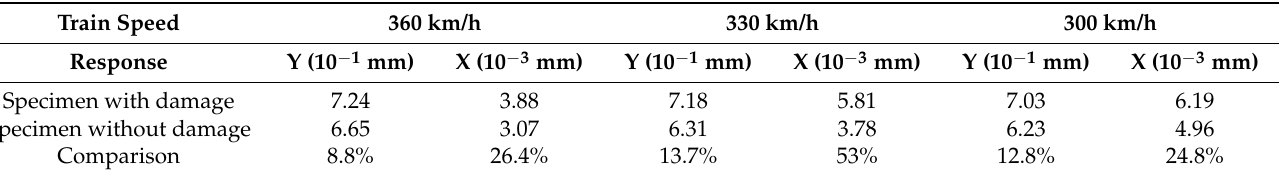
Figure 28. Responses of the composite beam at a train speed of 300 km/h in the case of T-2. 5. Conclusions In this paper, an elaborate FEM of a composite beam with group studs is established based on the ABAQUS platform, and an “M” type cyclic load is applied. On this basis, the FEM of the push-out and pull-out tests of the existing damaged and undamaged local specimens was established. Then, a numerical simulation was carried out to analyze the concrete slab damage and the degradation of the connection. The coupling system of a high-speed train ballastless track–composite beam was established, in which the macro- scopic constitutive model of the connection was introduced. Finally, the influence of the connection degradation on the overall behavior of the coupling system under the condi- tions of single-train driving and a two-train rendezvous was analyzed. (1) For the vibration characteristics of the area without a stud constraint at the com- posite beam interface, there is a certain phase difference between the acceleration time curve of the concrete slab and the steel beam at the local peak of the acceleration time curve of each specimen. The displacement time curve of each specimen is basically cyclic, and the trend is that the concrete slab and the steel beam are separated at the peak of the